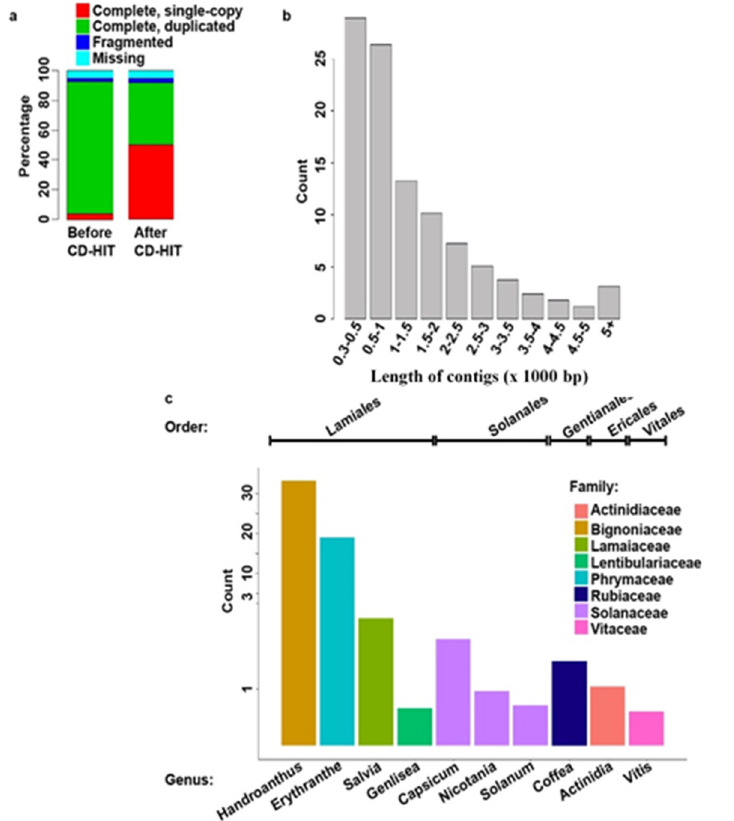
Figure 1. Statistics of the transcriptome assembly. ( a ) BUSCO results showing the transcriptome completeness and duplication level both before and after consolidating the redundant sequences using CD-HIT-EST; ( b ) length distribution of the assembled transcripts in basepair (bp); ( c ) the number of S. hispanica sequences matching to the top ten genera belonging to eight plant families. The x-axis shows the top ten genera; the y-axis shows the number of genes (×1000).